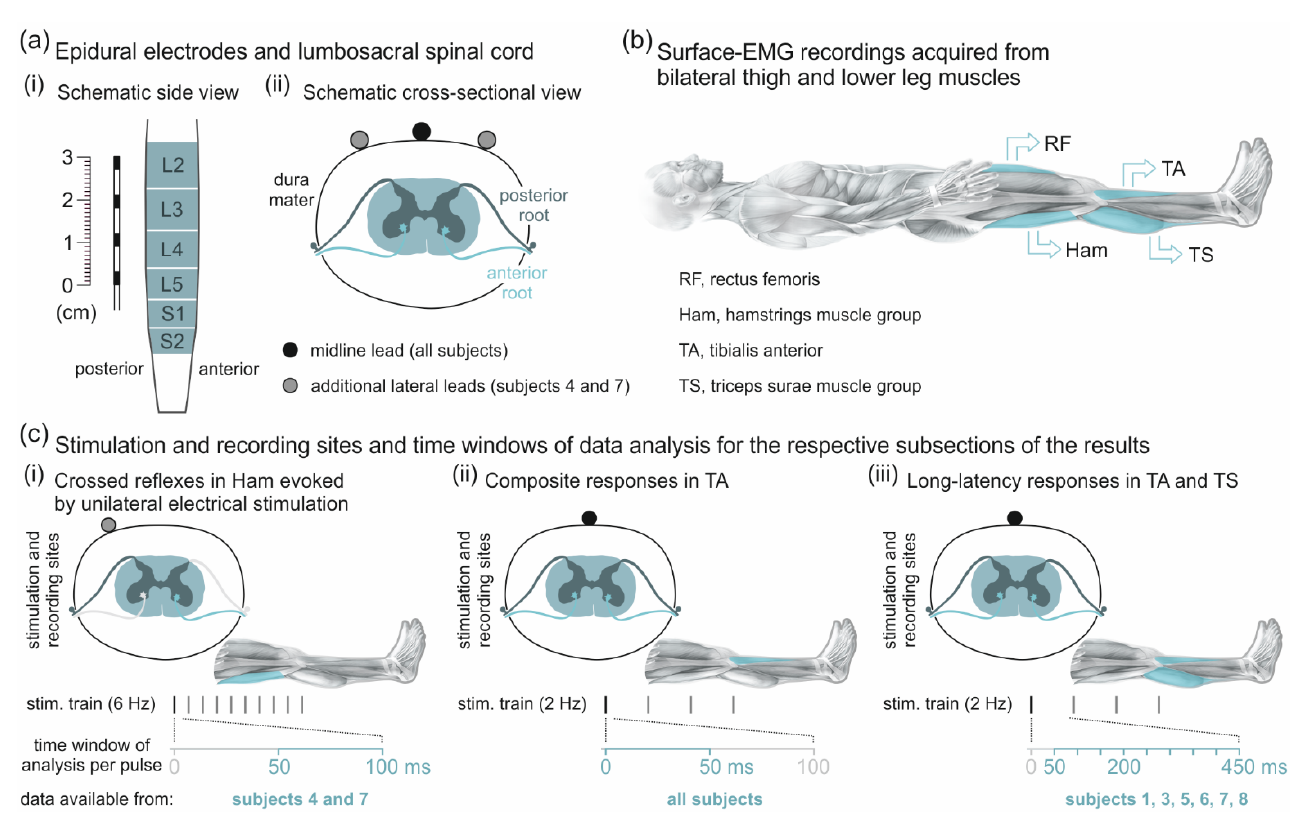
Figure 1. Overview of epidural electrical stimulation, EMG recording, and data analysis. ( a ) Percutaneous linear lead with four cylindrical electrodes (black rectangles) and lumbar (L) and upper sacral (S) spinal cord segments innervating lower-extremity muscles; ( i ) dimensions and ( ii ) electrode positions with respect to spinal cord and roots. ( b ) Surface-EMG locations; all recordings were conducted in the supine position. ( c ) Stimulation and recording sites, stimulation frequencies, and stimulus-triggered time windows of data analysis for the three different response types. stim.,